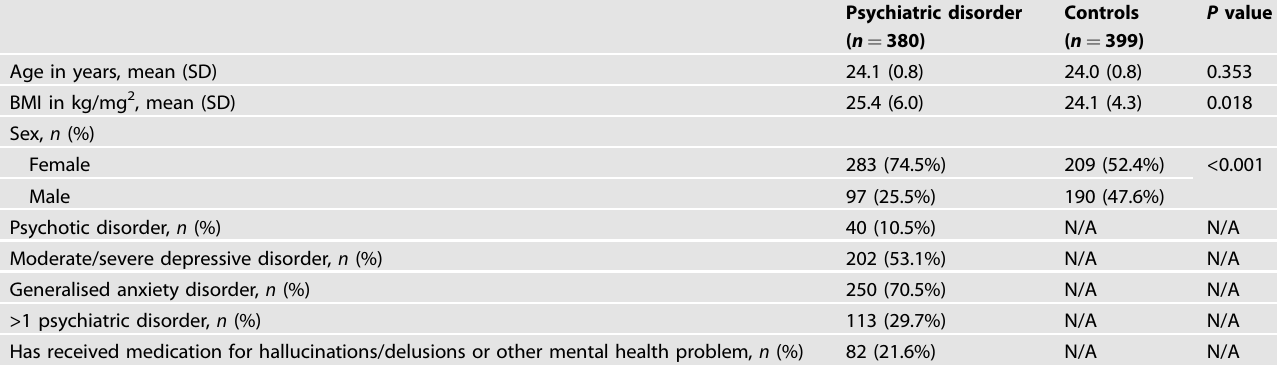
Table 1. Characteristics of the study